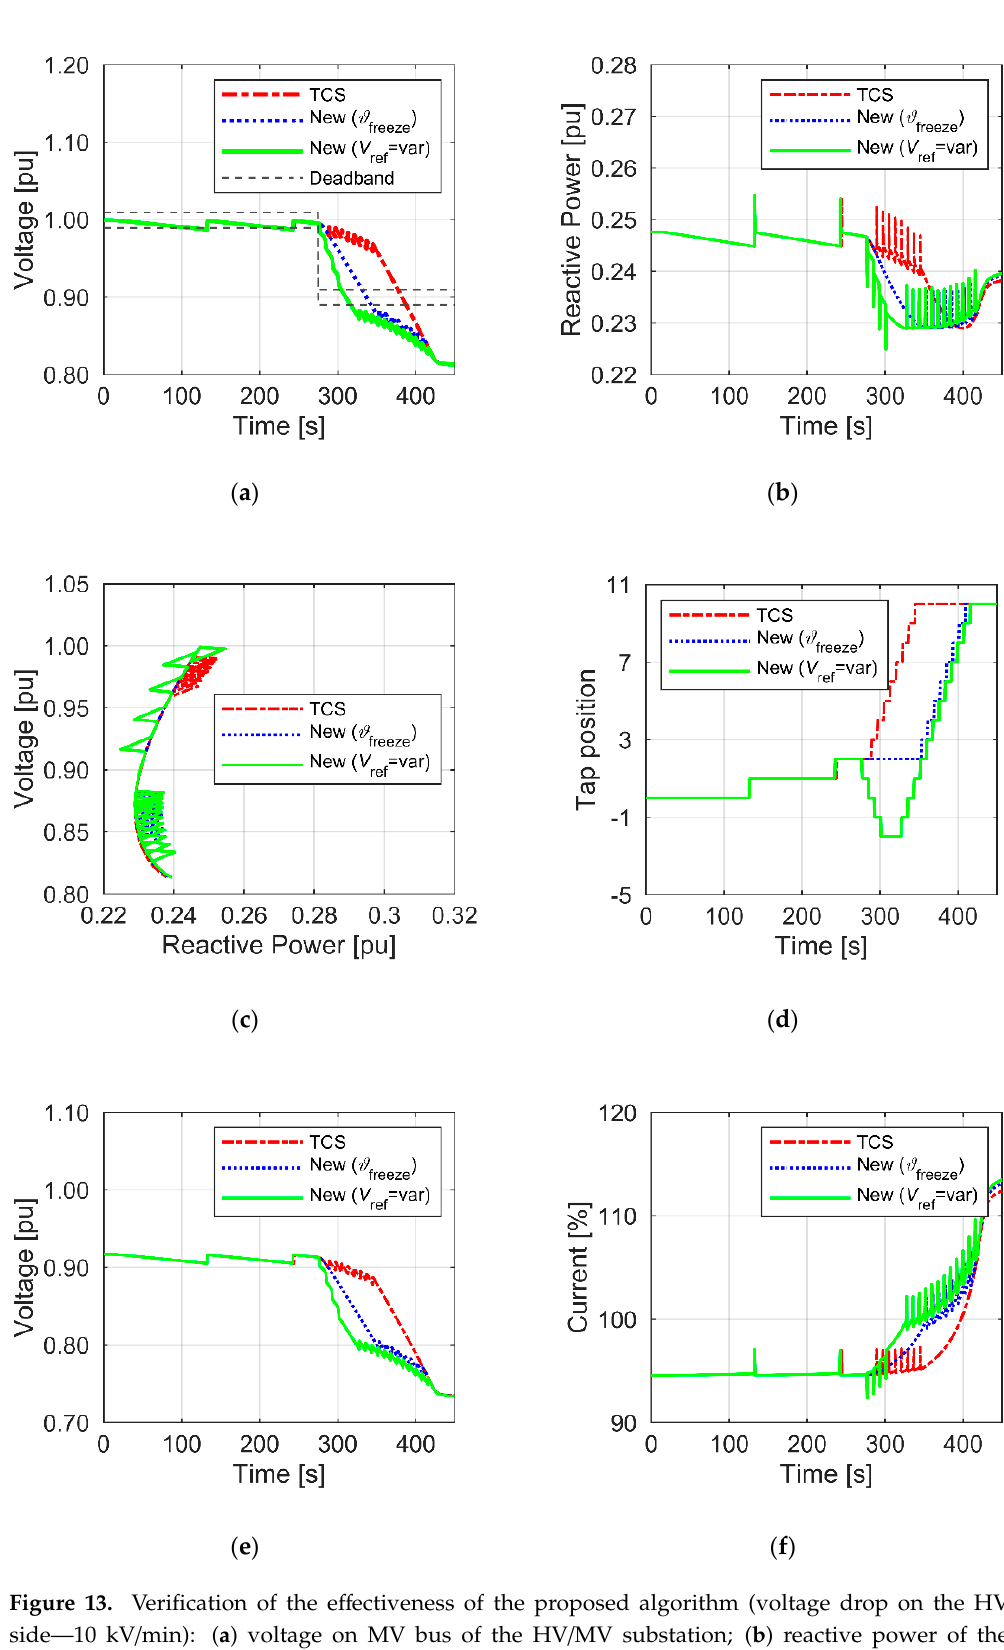
Figure 13. Verification of the effectiveness of the proposed algorithm (voltage drop on the HV side—10 kV/min): ( a ) voltage on MV bus of the HV/MV substation; ( b ) reactive power of the transformer; ( c ) characteristics V MV = f( Q MV ); ( d ) tap position; ( e ) voltage of loads; ( f ) I RMS of the asynchronous motor (expressed as a percentage of the rated current).